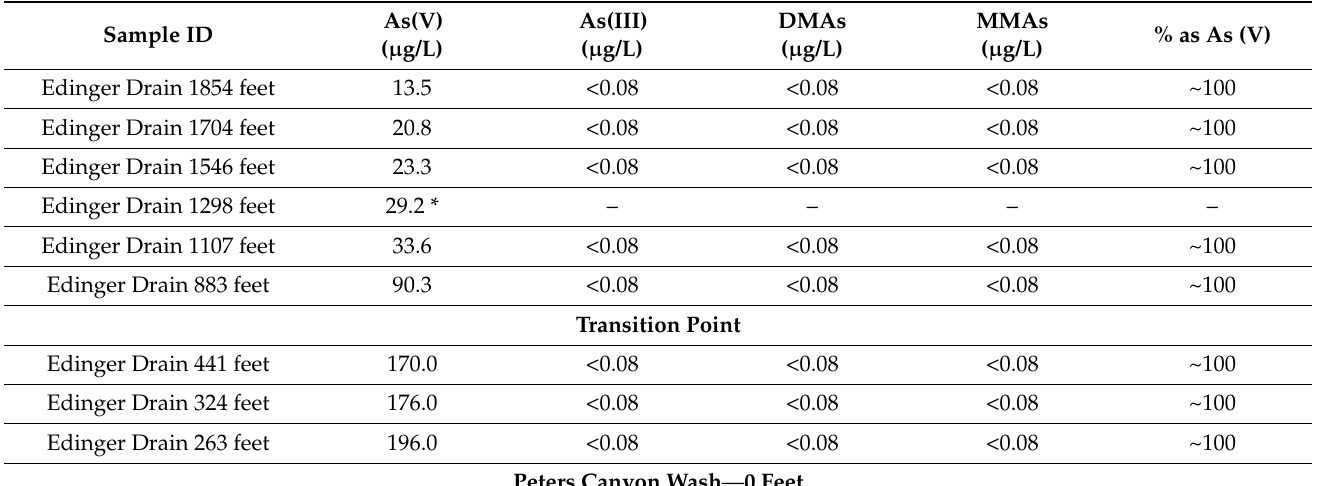
Table 4. Arsenic Speciation Data for Edinger Drain—Groundwater Seeps, March